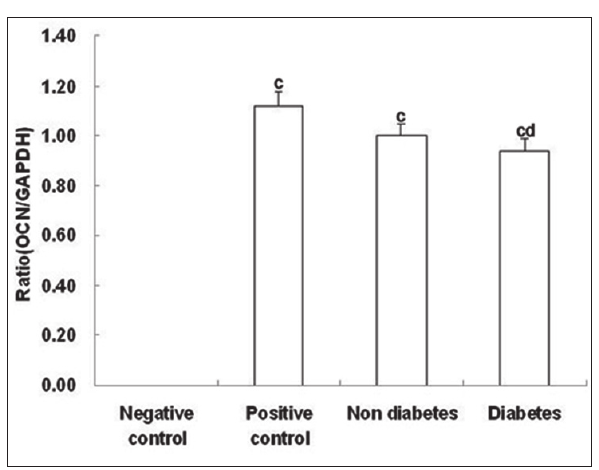
Fig. 5. OCN mRNA expression in HUMSC co-cultured with non-diabetic osteoblasts or diabetic osteoblasts for 21 days. There was no OCN mRNA expression in negative control group and taken as 0%. c P <0.01 vs. control group d P >0.05 vs. non-diabetic group. The experiment was performed three